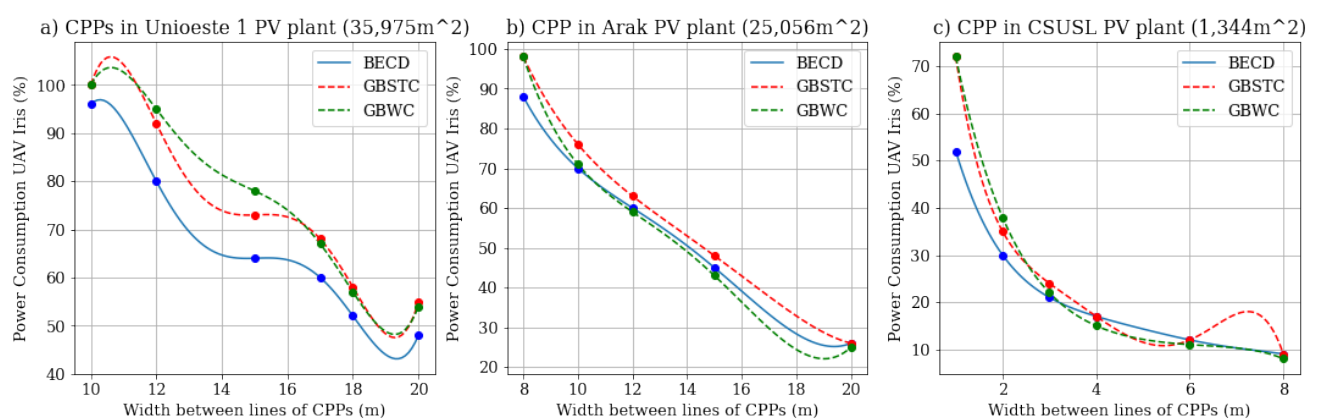
Figure 16. Performance test of UAV 3DR Iris varying the CPP